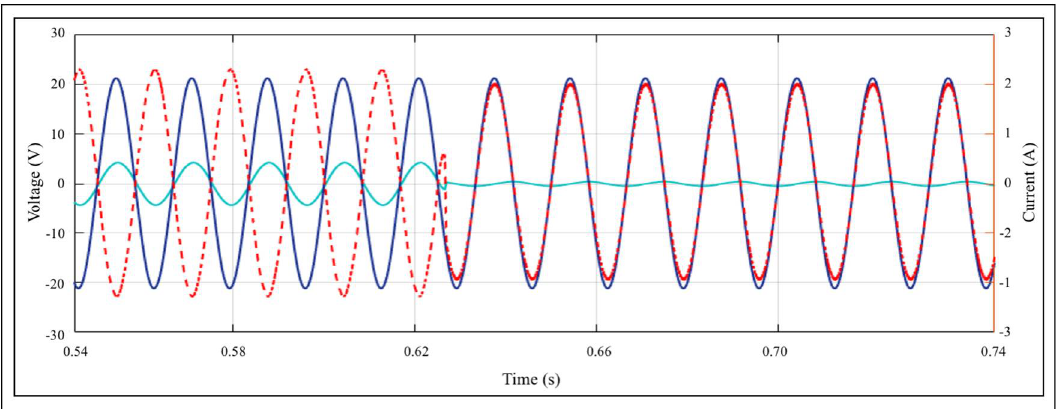
Figure 7. The transitory response, the behavior of the waves of I AC , V AC and i L